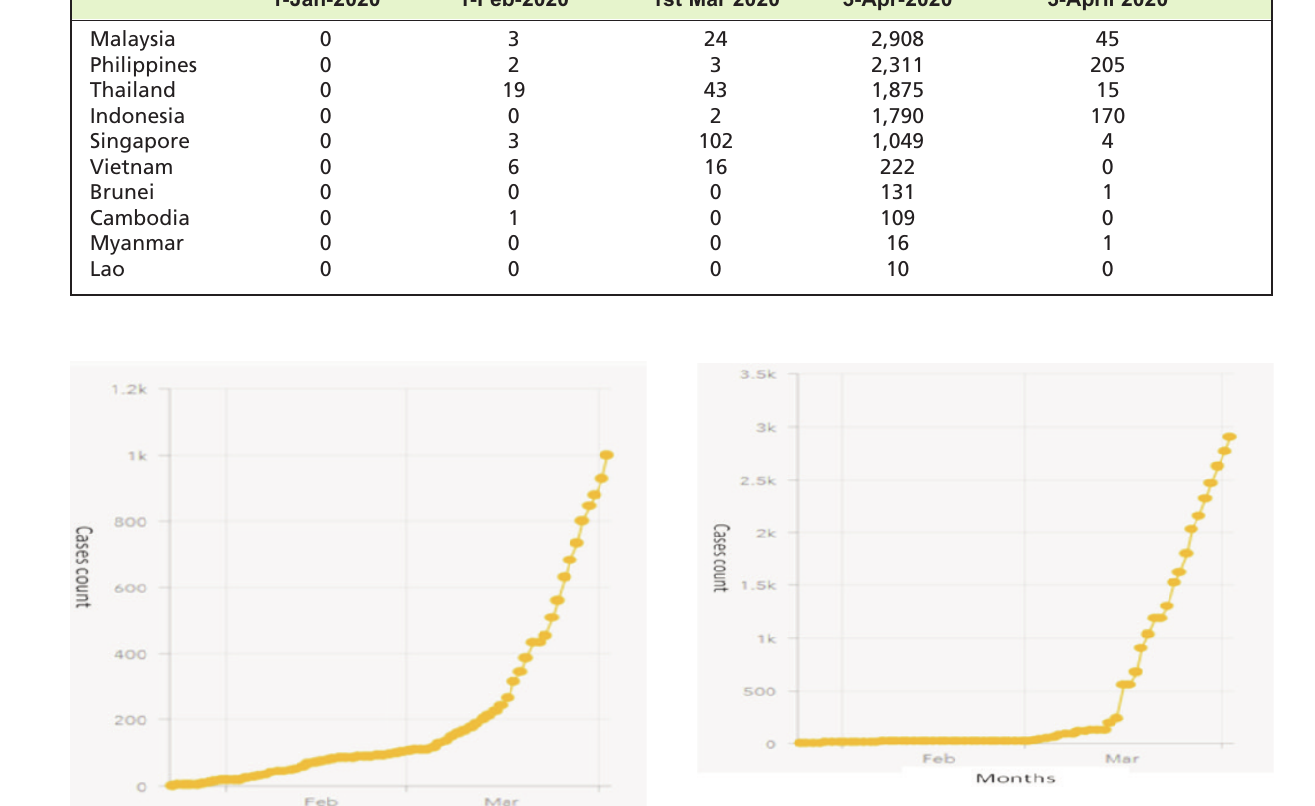
Number of COVID-19 cases in ASEAN countries and cumulative no of related deaths 10 Table I: Cumulative no. of confirmed cases